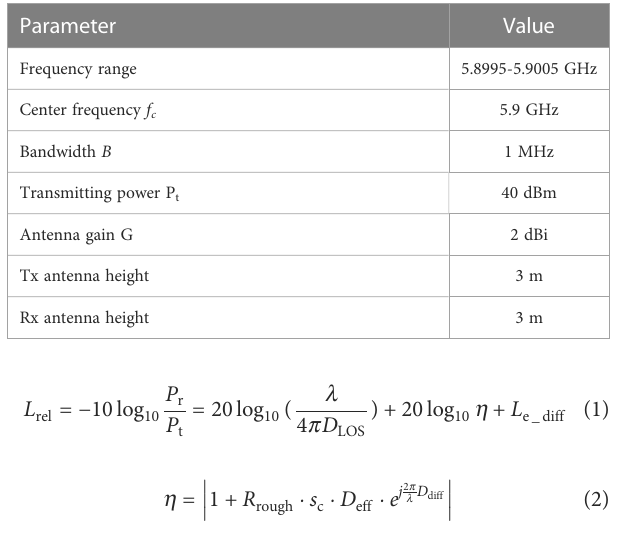
TABLE 1 System parameters.